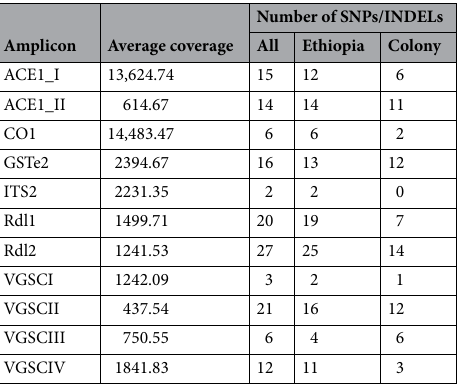
Table 1. Average amplicon coverage, and number of genetic variants